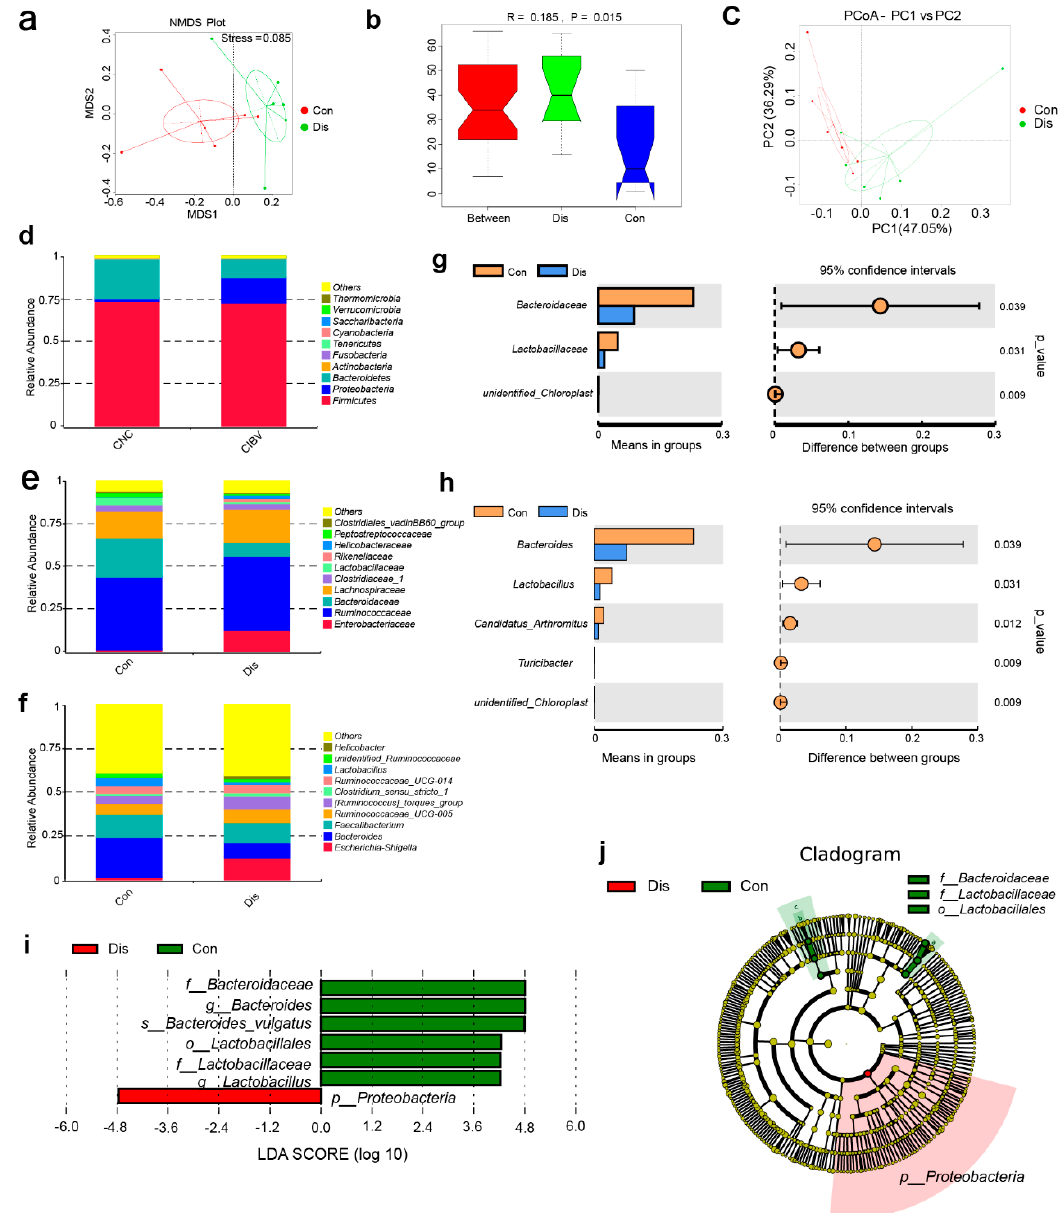
Figure 4. NIBV infection resulted in gut microbiota dysbiosis. ( a ) Nonmetric multidimensional scaling (NMDS) showing the difference in bacterial communities according to Bray–Curtis distance. ( b ) Analysis of similarity (ANOSIM) analysis of the beta diversity of the samples significantly separating the groups when R > 0 and p < 0.05. ( c ) Principle coordination analysis (PCoA) plot of similarities between the different groups. The top 10 relative abundances of bacteria at the phylum ( d ), family ( e ), and genus ( f ) levels in cecal content samples from the Con and Dis groups. The difference in species analysis between the Con and Dis groups at the family ( g ) and genus ( h ) levels according to a t-test. ( i ) The linear discriminant analysis (LDA) value distribution histogram shows species with an LDA ≥ 4. ( j ) Cladogram showing the most differentially abundant taxa identified by linear discriminant analysis effect size (LEfSe).